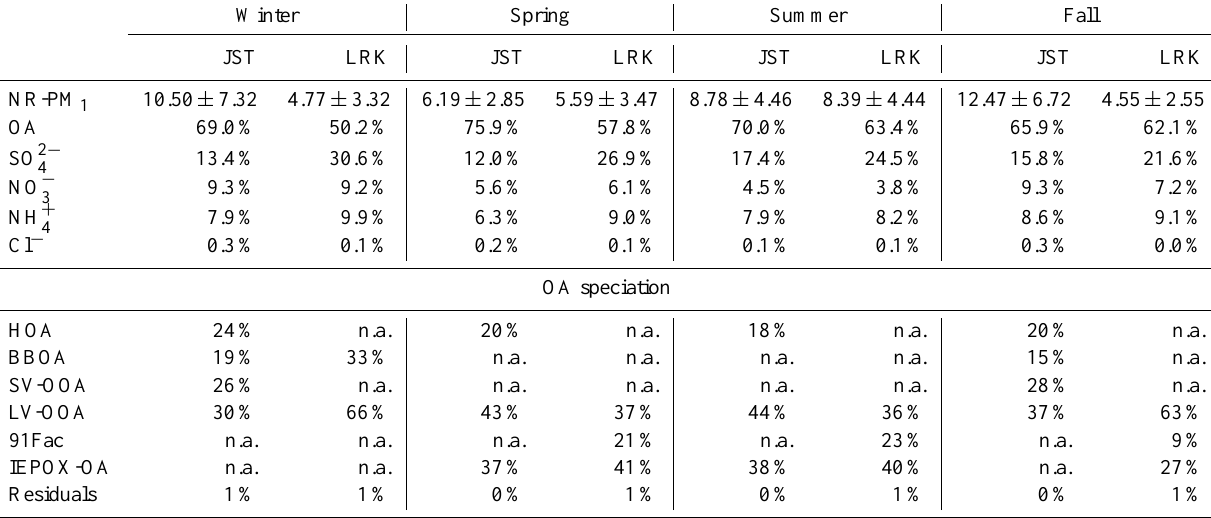
Table 2. Seasonal averaged mass concentrations of non-refractory PM 1 (NR-PM 1 ) in µgm − 3 , percent contributions of organic and inorganic species measured by the Aerodyne ACSM and PMF factors resolved from Atlanta, GA (JST site), and Look Rock, TN (LRK site), during 2012 and